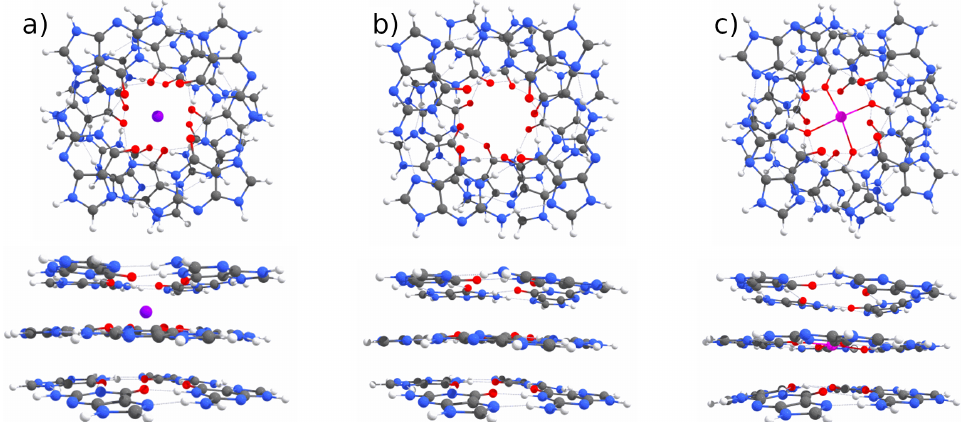
Figure A1. The structures of three layers of stacking guanine quartets, optimized at the QM level of theory, shown as simplified (i.e., lacking single-stranded motifs) representations of G-quadruplexes with coordinated K + ( a ), Na + ( c ), and without cations ( b ). Note that without flexible loops, the quartets remain intact even without cation coordination, thanks to the cancellation of the dipole moments within the G-tetrads combined with the circular network of the hydrogen bonds via Hoogsteen edges. The adjacent G-tetrads are held together by the quadrupole interactions between pi-stacking